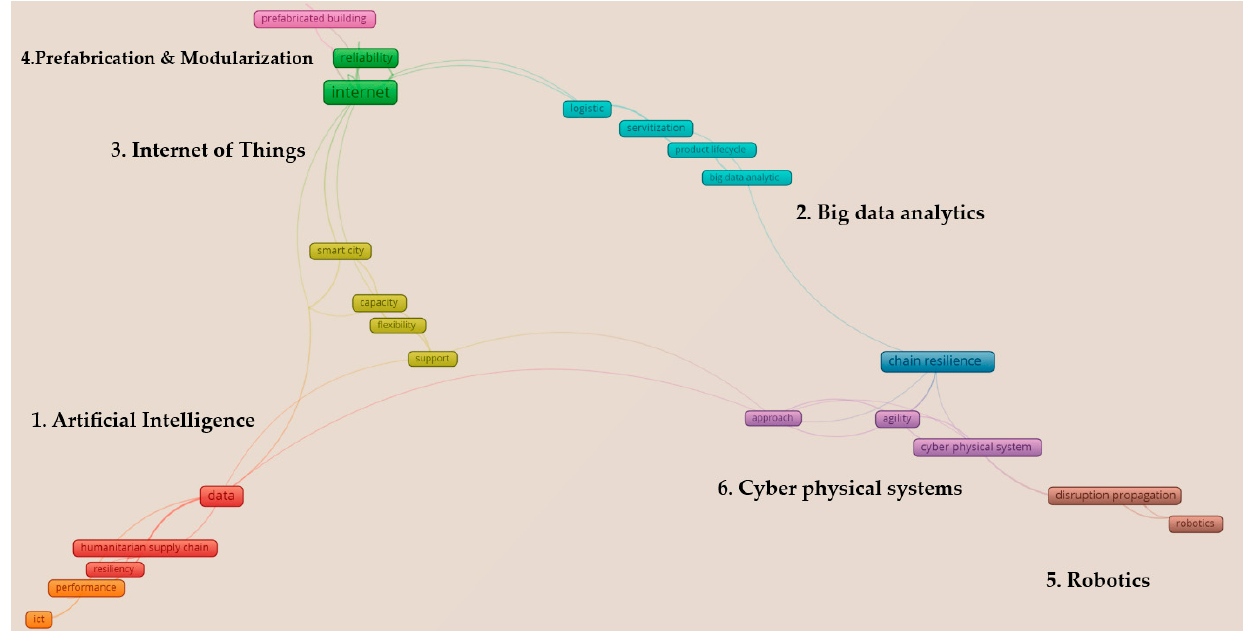
Figure 9. Co-occurrence analytical map of keywords created using bibliographic analysis of the 70 retrieved articles.